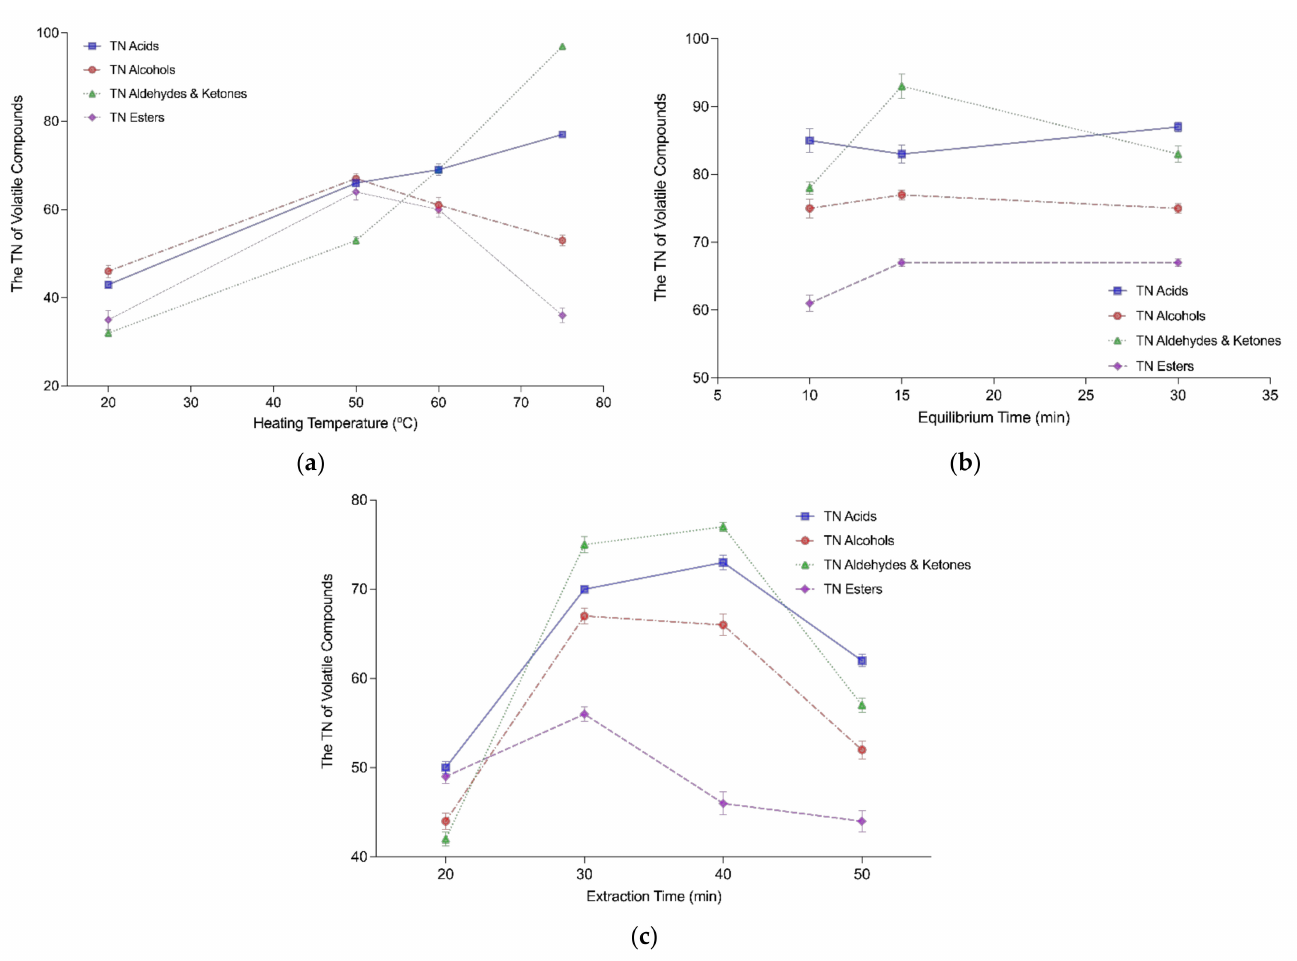
Figure 2. Effect of different extraction parameters of HS-SPME on the total number (TN) of com- pounds of the different chemical families in sourdough: heating temperature ( a ); equilibrium time ( b ); extraction time ( c